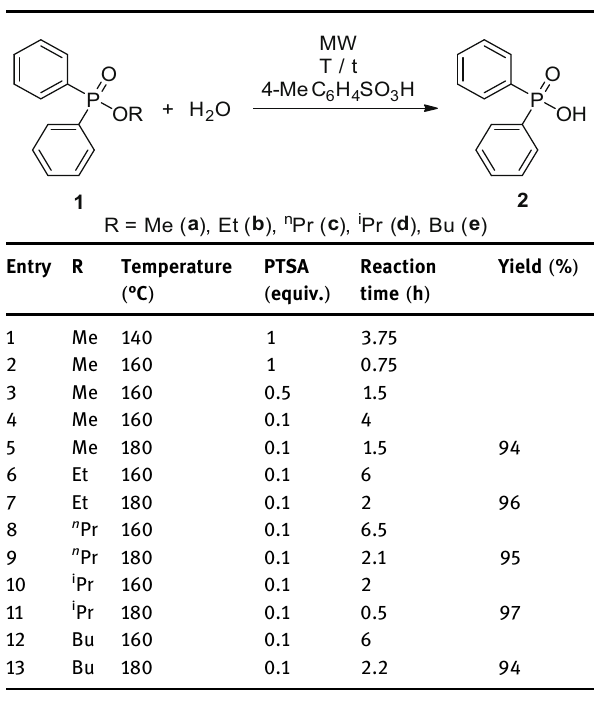
Table 2: Pseudo - fi rst - order rate constants ( k Δ and k MW ) obtained for the thermal HCl - catalyzed and MW - assisted PTSA - catalyzed hydrolyses